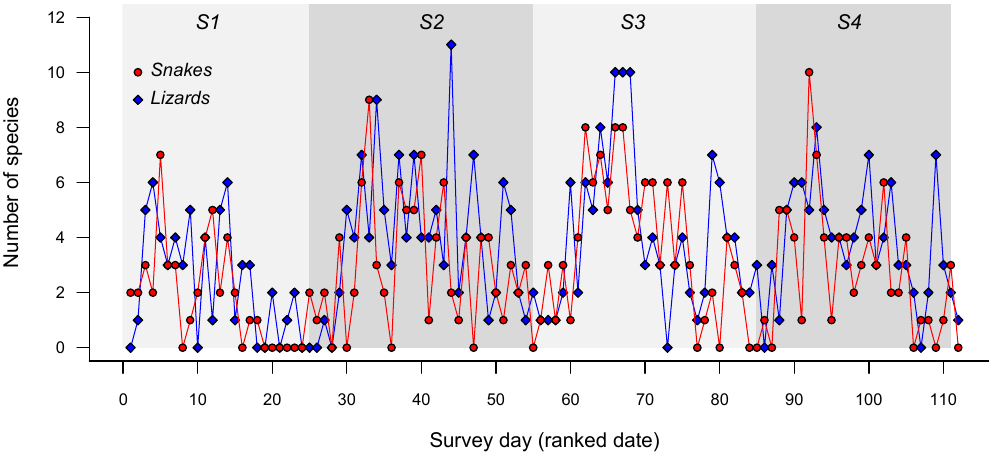
Figure 3. Numbers of species of snakes and lizards detected per sampling day during 2016–2018